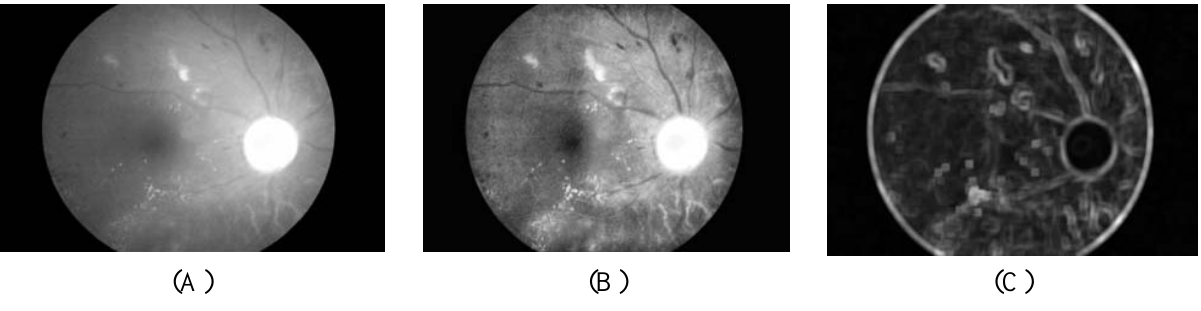
Figure 1 . Pre-processing result. (A) Original I band. (B) I band after pre-processing. (C) Standard deviation of